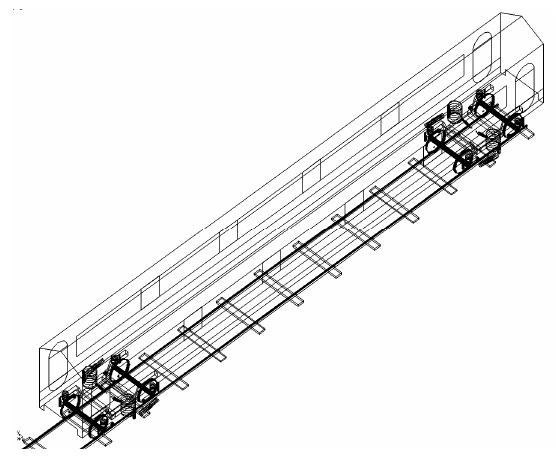
Figure 4. Integrated model of vehicle–track.